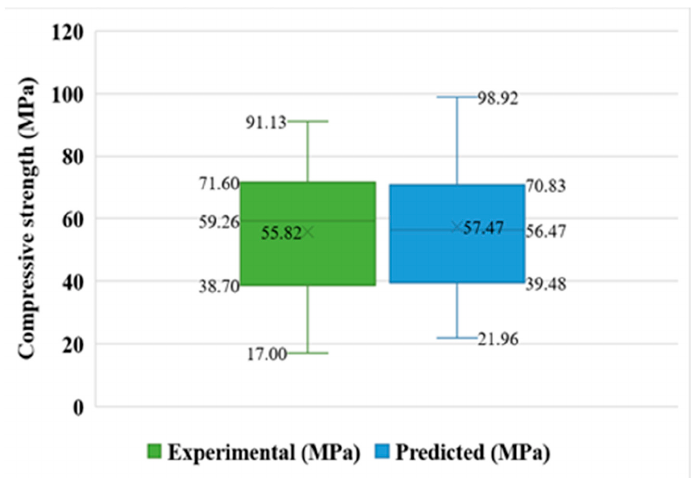
Figure 9. Box plot for predicted and experimental outcomes from MLP model.